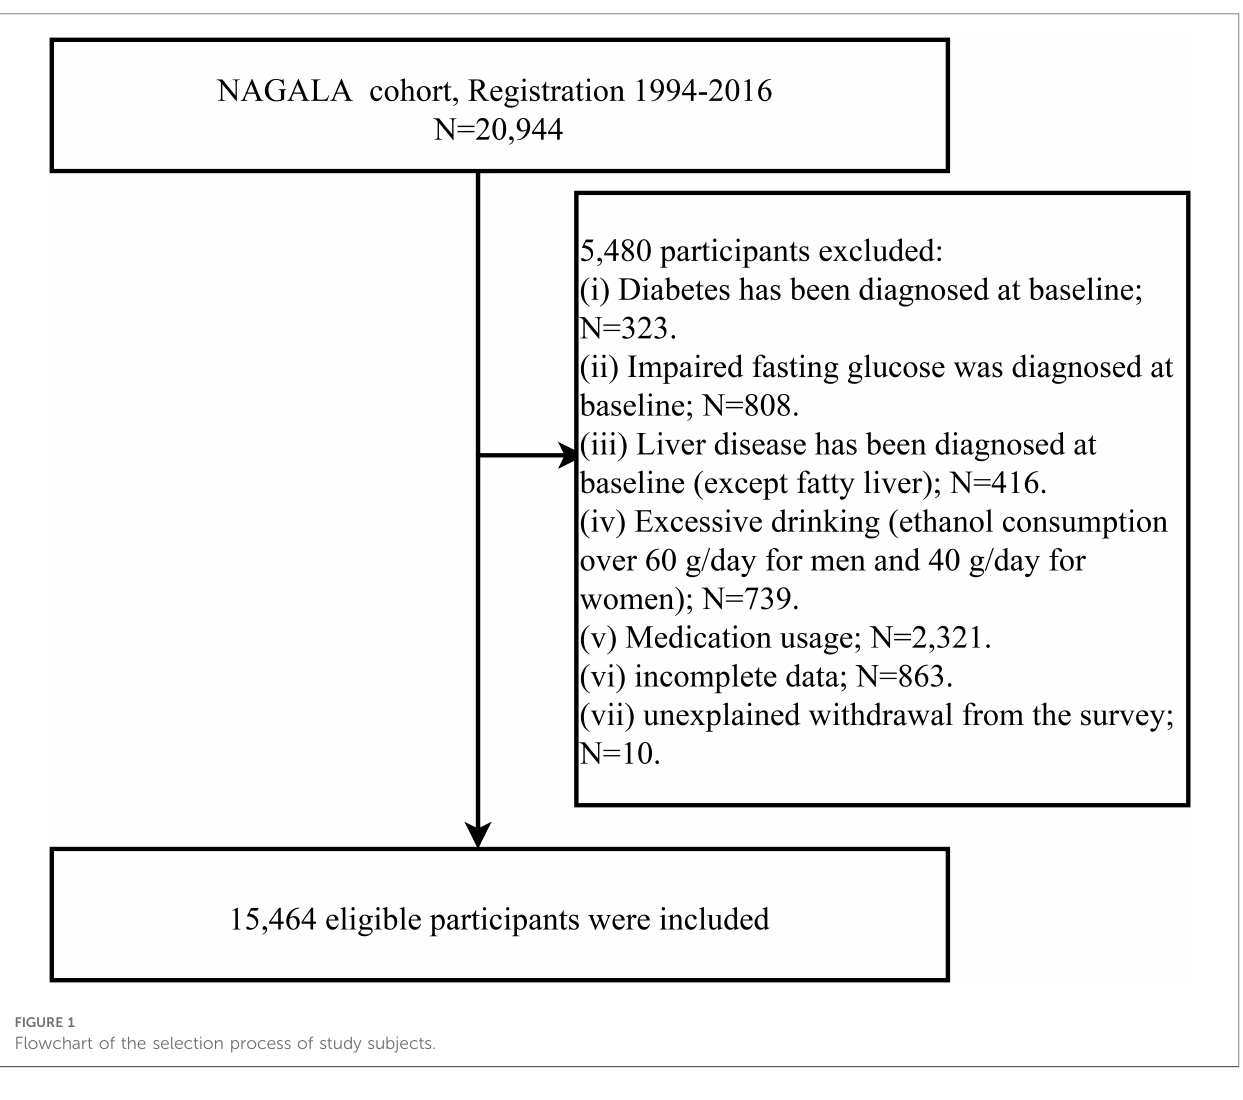
FIGURE 1 Flowchart of the selection process of study